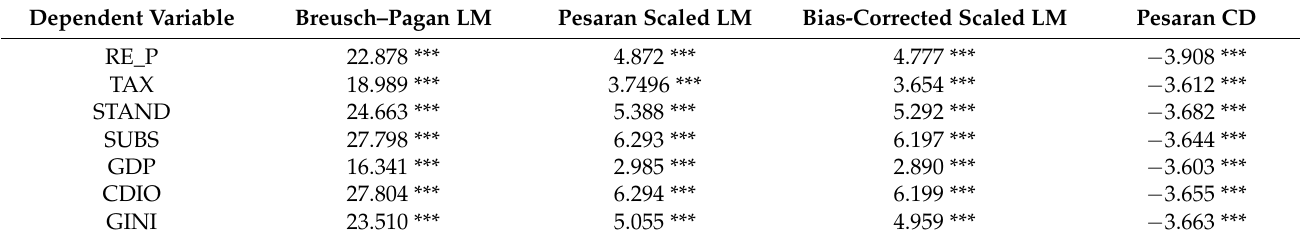
Table 5. Cross-sectional dependency test (CD) for model 3.